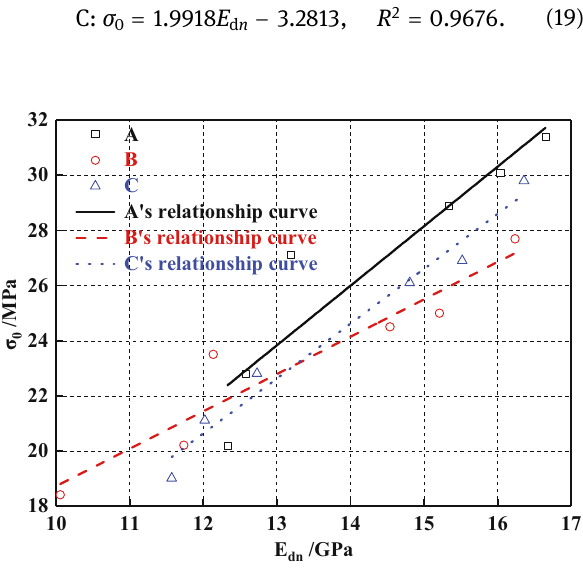
Figure 20: Relationship σ 0 with E d n